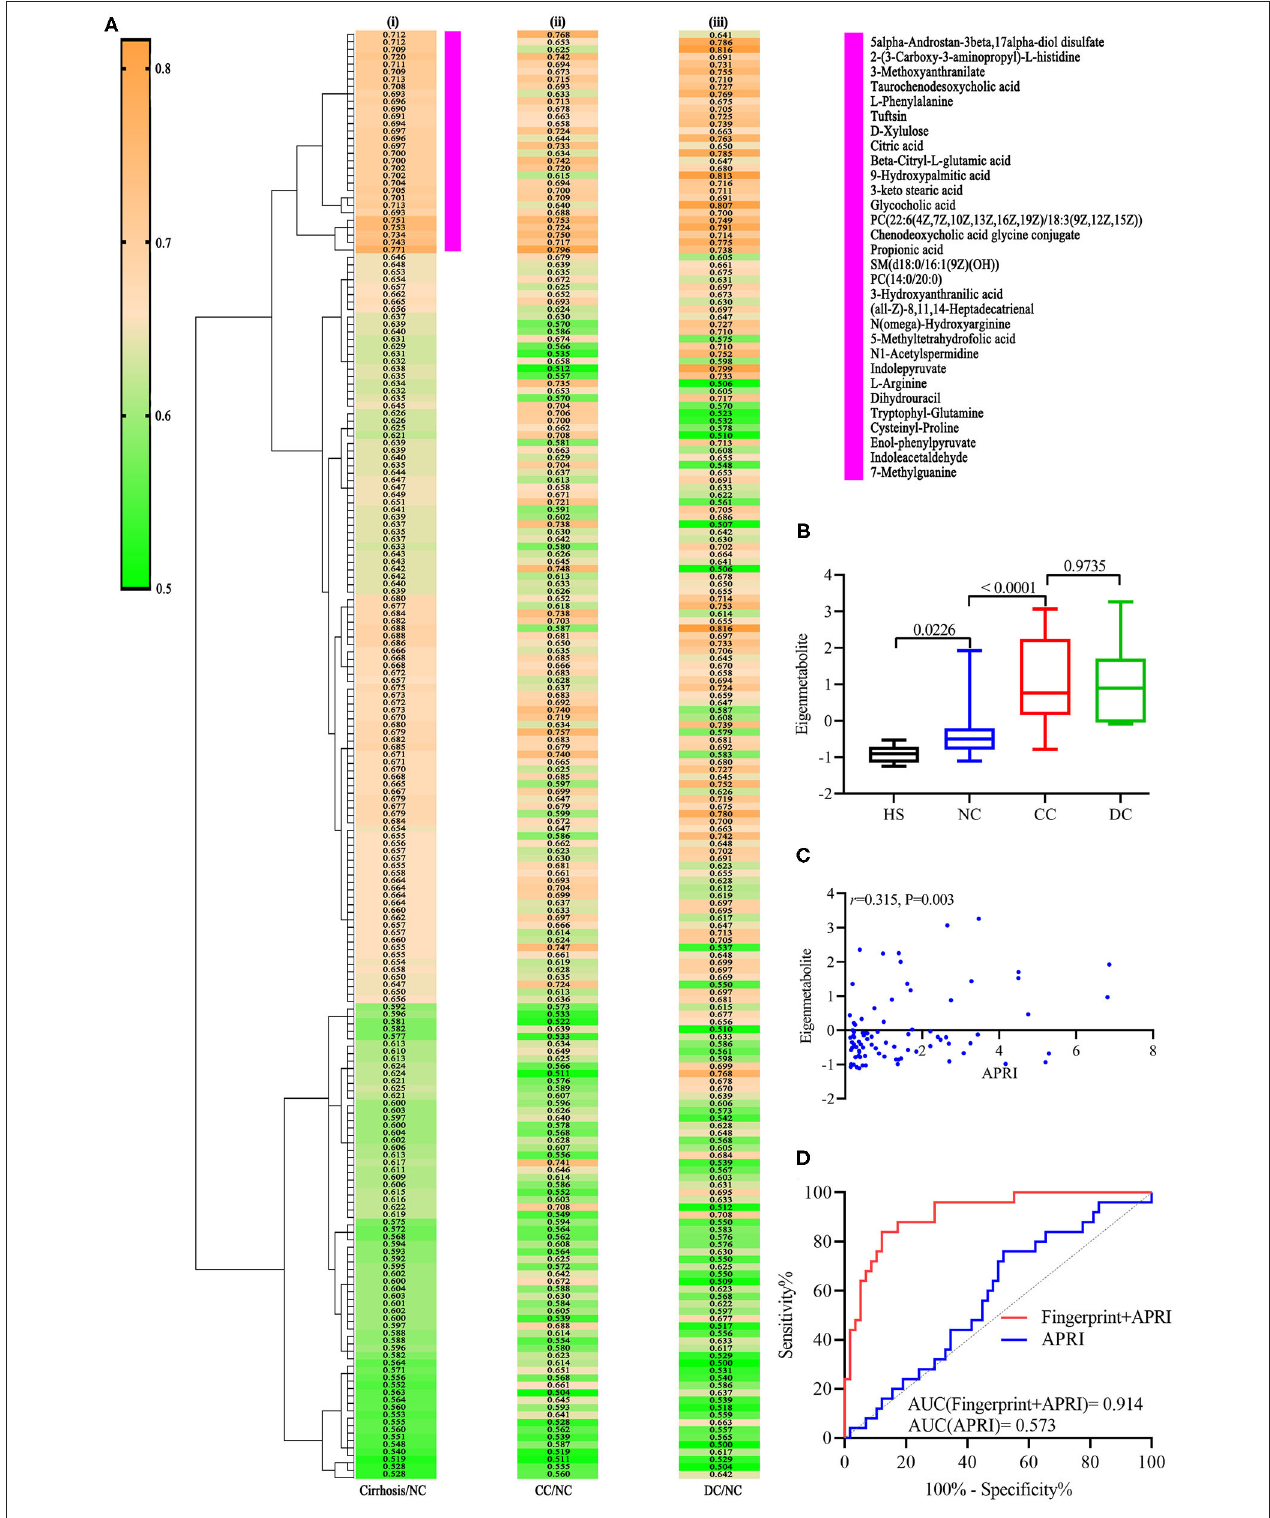
FIGURE 2 | Identification of cirrhosis-related metabolic fingerprint. (A i ) Hierarchical cluster analysis of AUC and P differentiation between cirrhosis and non-cirrhosis groups. (A ii ) Corresponding metabolites in differentiating between DC and NC groups. (A iii ) Indicates corresponding metabolites in differentiating between DC and NC groups. (B) shows increasing trend of eigenmetabolite across different stages of chronic DILI, from HS to DC. (C) Indicates significantly positive correlation relationship between cirrhosis-associated eigenmetabolite and APRI score. (D) is ROC curve analysis for metabolic fingerprint (eigenmetabolite) and APRI score, in discriminating cirrhosis from non-cirrhotic patients with chronic